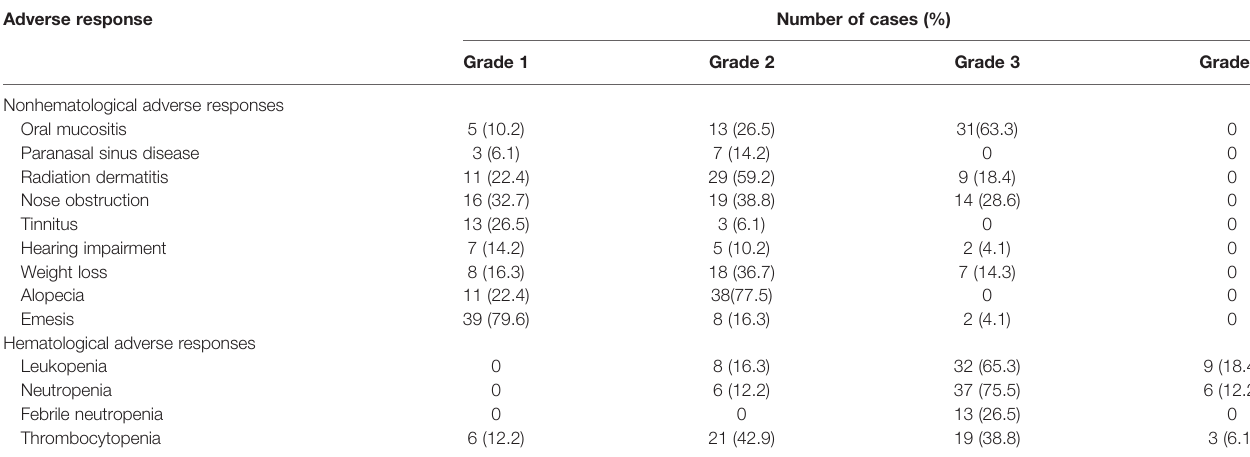
TABLE 5 | Incidence of non-vision-related adverse responses.